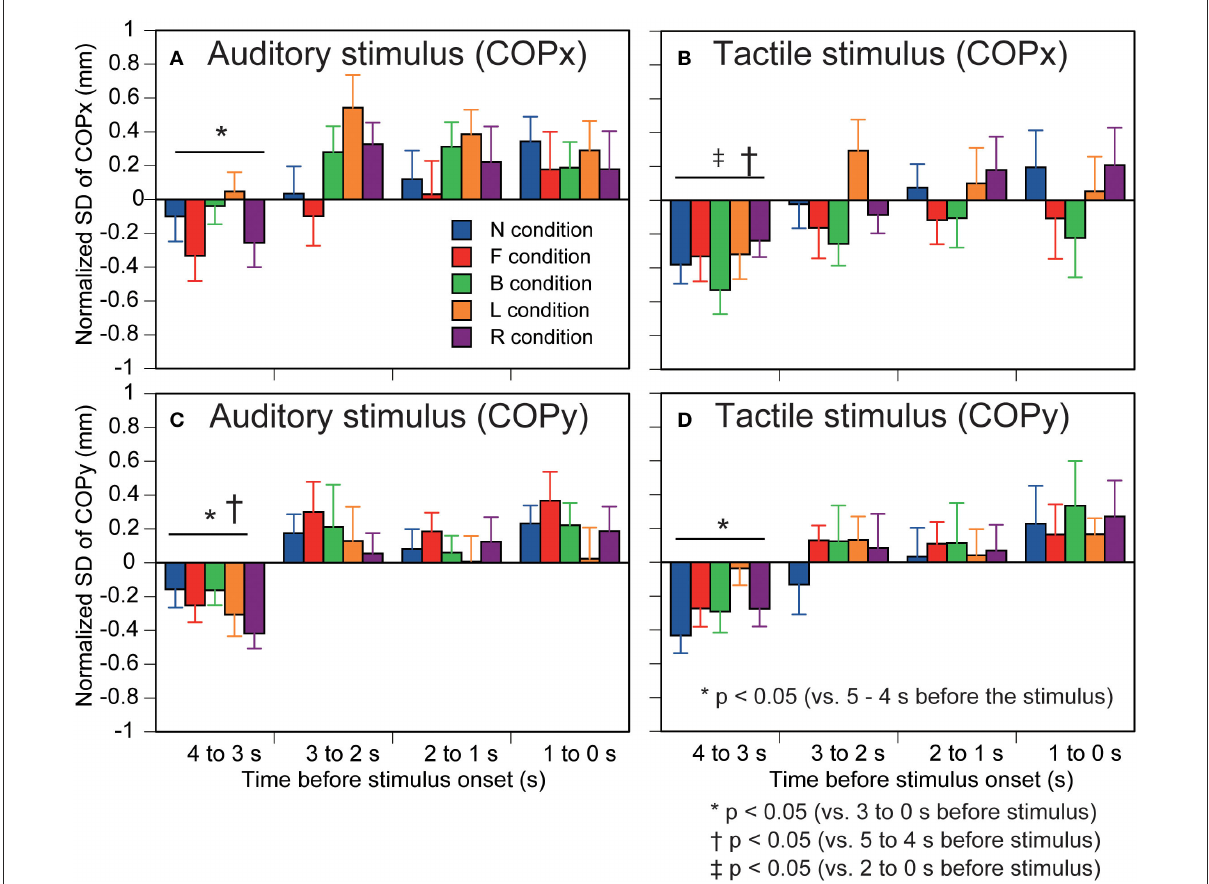
FIGURE4 Effect of predicting the auditory or tactile stimulus on the standard deviation of COP. Auditory stimulus trial blocks are in the left panels (A,C) and tactile stimulus trial blocks are in the right panels (B,D) . The upper panels are COPx (A,B) and lower panels are COPy (C,D) . Bars indicate the mean, and error bars indicate standard errors of the mean. The data are normalized by subtracting the average value at 1–0s before the onset of the visual cue (5–4s before the stimulus) from the values averaged at each 1s in the time window between 4 and 0s before the stimulus. N, trials with the cue predicting non-stimulation; F, trials with the cue predicting the stimulus to the forehead; B, trials with the cue predicting the stimulus to the back of the head; L, trials with the cue predicting the stimulus to the left side of the head; R, trials with the cue predicting the stimulus to the right side of the head.